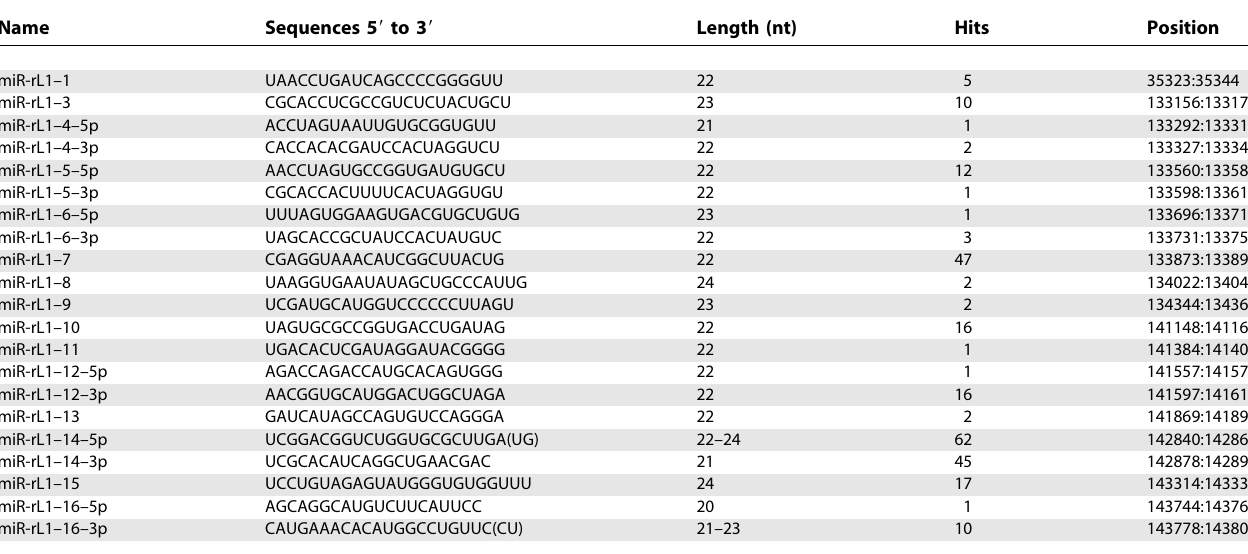
Table 2. Sequence and Genomic Location of rLCV miRNAs Cloned from the 211–98 Cell